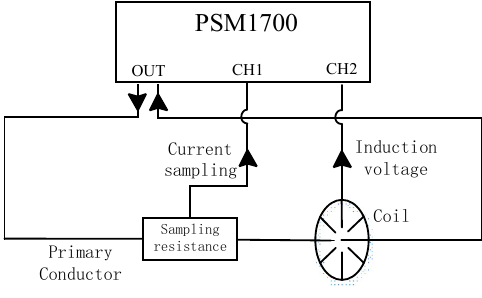
Figure 10. Physical drawing of coil 1–4.